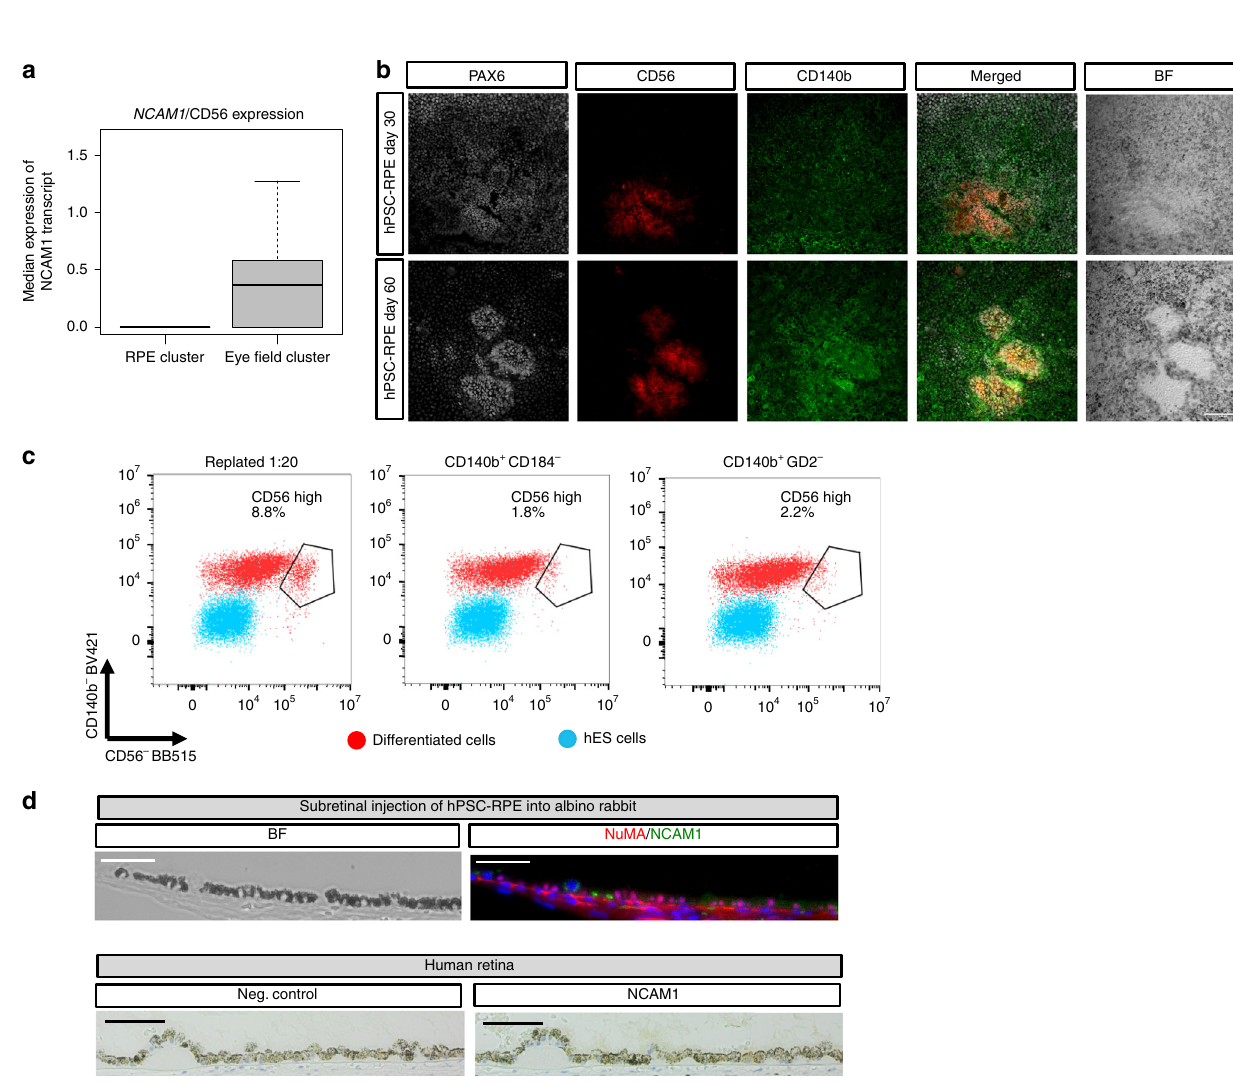
Fig. 5 CD56 as a potential surface marker for immature hPSC-RPE. a Box plot comparing NCAM1 /CD56 median expression between the RPE and eye- fi eld clusters measured by the 10x Genomics single-cell RNA-sequencing experiment described in Fig. 4. Eye- fi eld cluster: Median = 0.36, minimum = 0.0, maximum = 1.66, interquartile range = 0.58; RPE cluster: Median = 0.0, minimum = 0.0, maximum = 1.38, interquartile range = 0.0. b Bright fi eld and immuno fl uorescent images showing the co-expression of the retinal progenitor marker PAX6 together with extracellular markers CD140b and CD56 in hPSC-RPE after 60 days of differentiation. c Flow cytometry dot plots comparing percentage of cells expressing high levels of CD56 cell surface protein at day 60 of differentiation in cells that were either replated or enriched for CD140b + /CD184 − or CD140b + /GD2 − at the 30-day replating step. d Upper: Bright fi eld and immuno fl uorescence pictures displaying the absence of CD56 (NCAM1) expression in albino rabbit retinas injected with pigmented hPSC- RPE cells. Lower: Bright fi eld immunohistochemistry pictures showing the absence of CD56 (NCAM1) in a human subretinal tissue section. Subretinal hPSC- RPE cells in albino rabbit were stained for human-speci fi c NuMa antigen to distinguish them from native RPE cells. Scale bars: b = 100 μ m; d = 50 μ CD184 or GD2 ef fi ciently eliminated the mesoderm con- tamination and reduced the fraction of eye- fi eld progenitors, suggesting that a sorting step could be implemented to achieve a more homogeneous cell product.